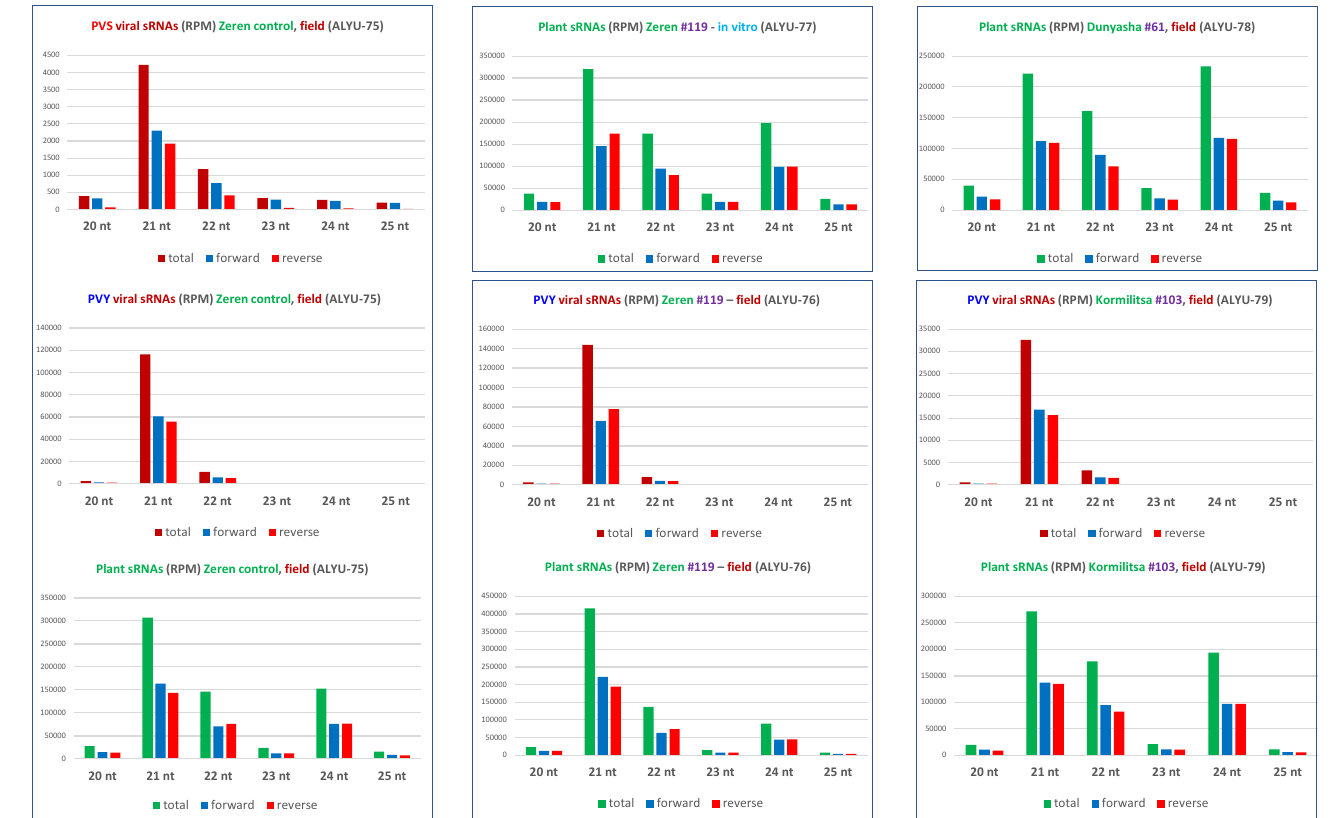
Figure 5. Size profiles of virus-derived and plant sRNAs. Redundant 20–25 nt sRNA reads from leaf samples of the non-transformed plant of cultivar Zeren (field plant ALYU-75) and the transgenic plant lines of cultivars Zeren (line #119: field plant ALYU-76 and in vitro plant ALYU-77), Dunyasha (line #61: field plant ALYU-78), and Kormilitsa (line #103: field plant ALYU-79) were mapped with zero mismatches to reference sequences of the reconstructed genomes of viruses (PVS and/or PVY) present in some of the plants (Dataset S1B) and the S. tuberosum genome. The mapped reads were sorted by size (20, 21, 22, 23, 24, and 25 nt) and polarity (total, forward, and reverse) and counted in reads per million (RPM) of total 20–25 nt reads in each library (Dataset S2D). The resulting counts are plotted as bar graphs and color-coded.